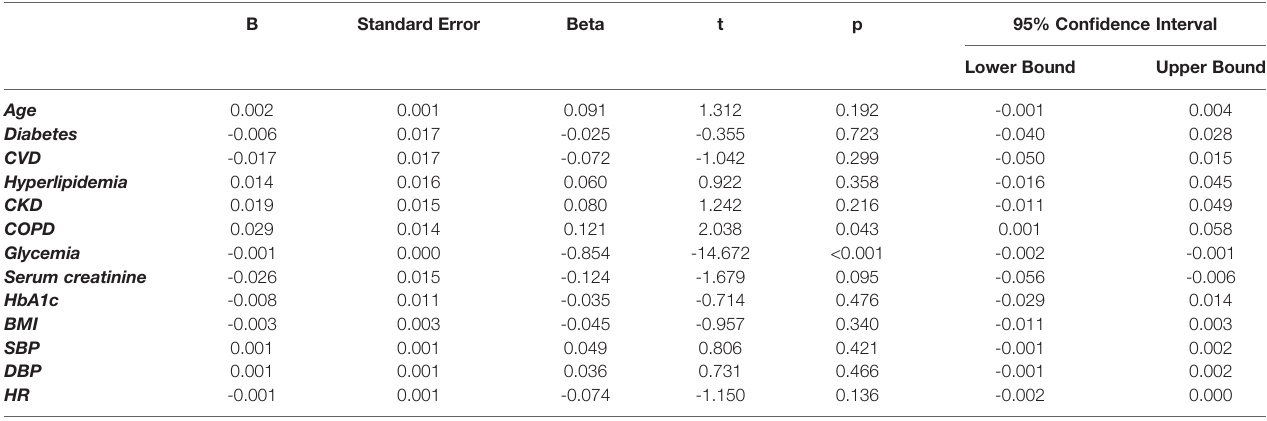
TABLE 2 | Linear regression analysis with 5mGS as a dependent